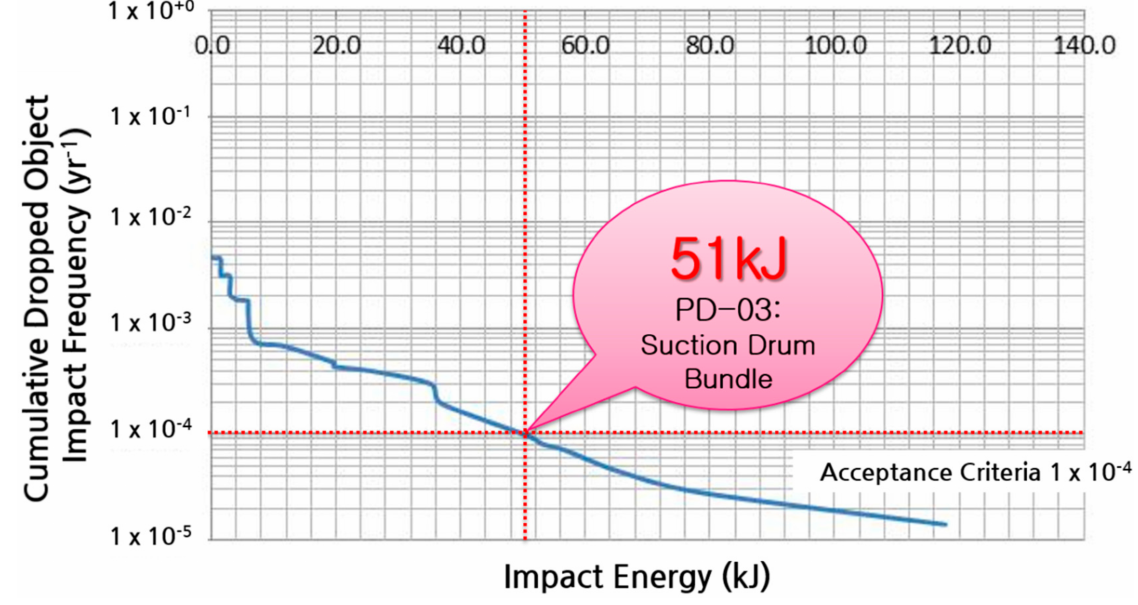
Figure 8. Impact energy exceedance curve.